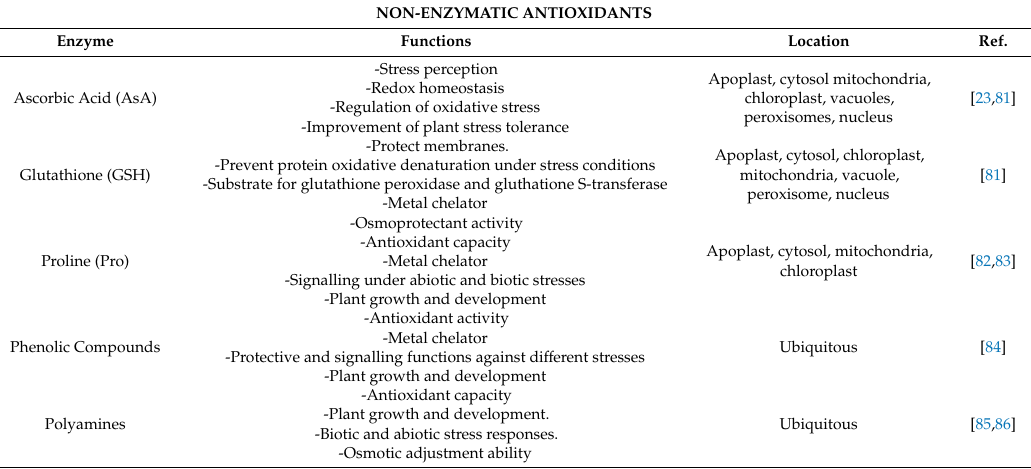
Table 2. Schematic overview of the non-enzymatic